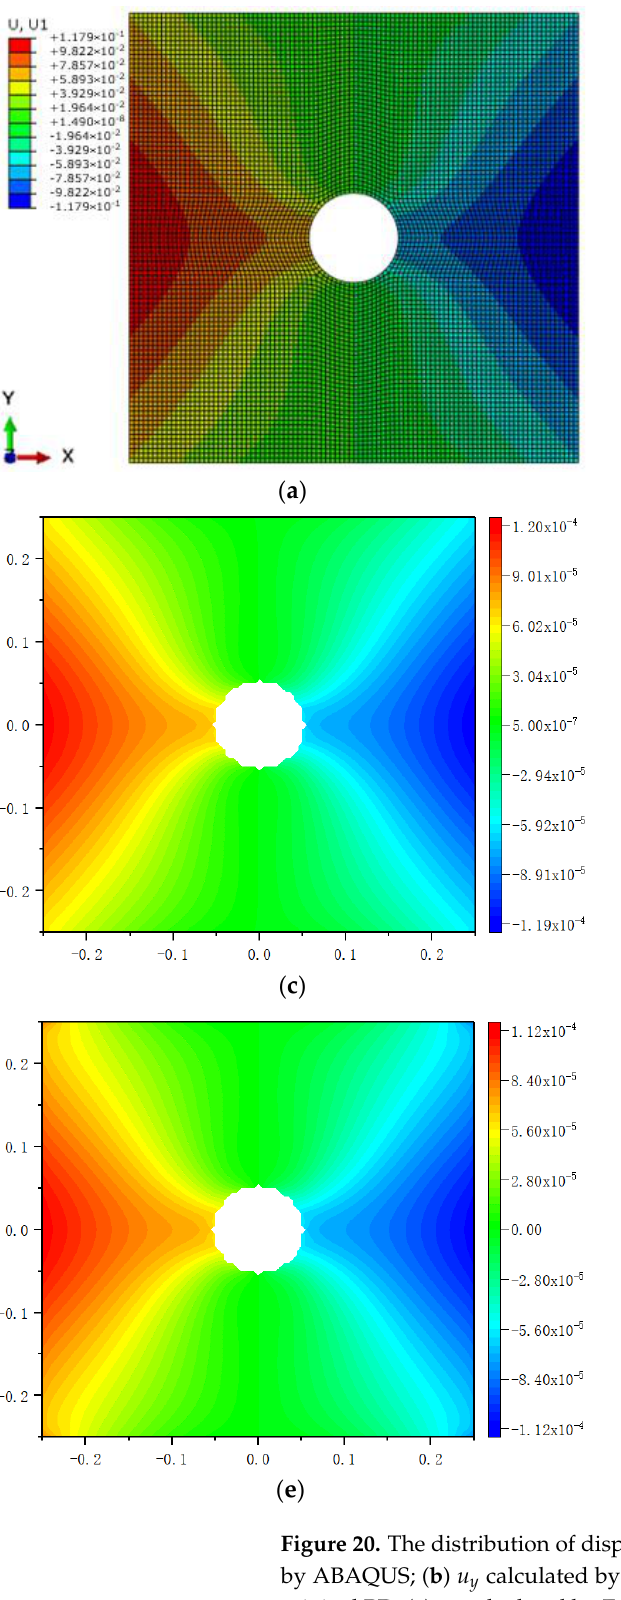
Figure 19. Convergence of displacement at x = − 0.125 m and y = − 0.125 m with time step.